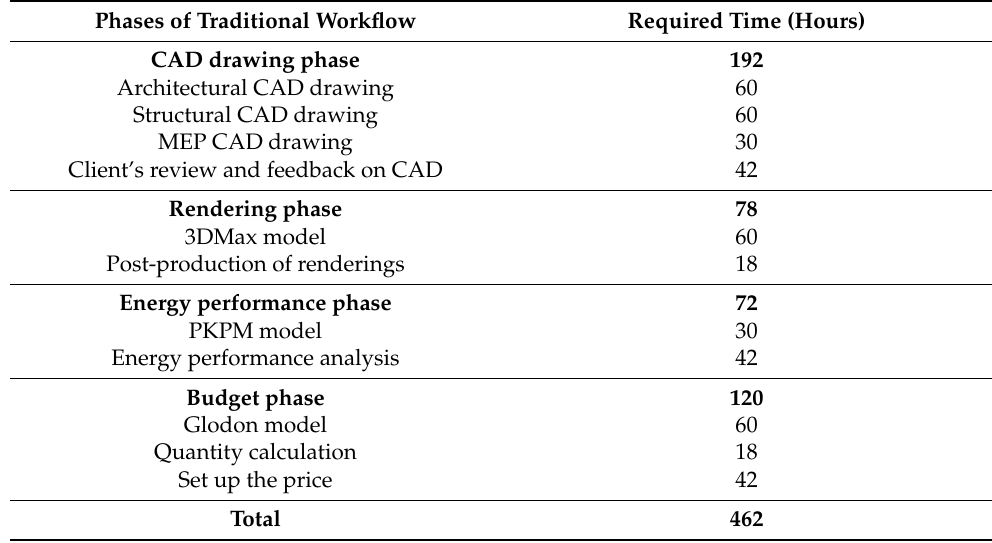
Table 2. Duration results of traditional workflow.